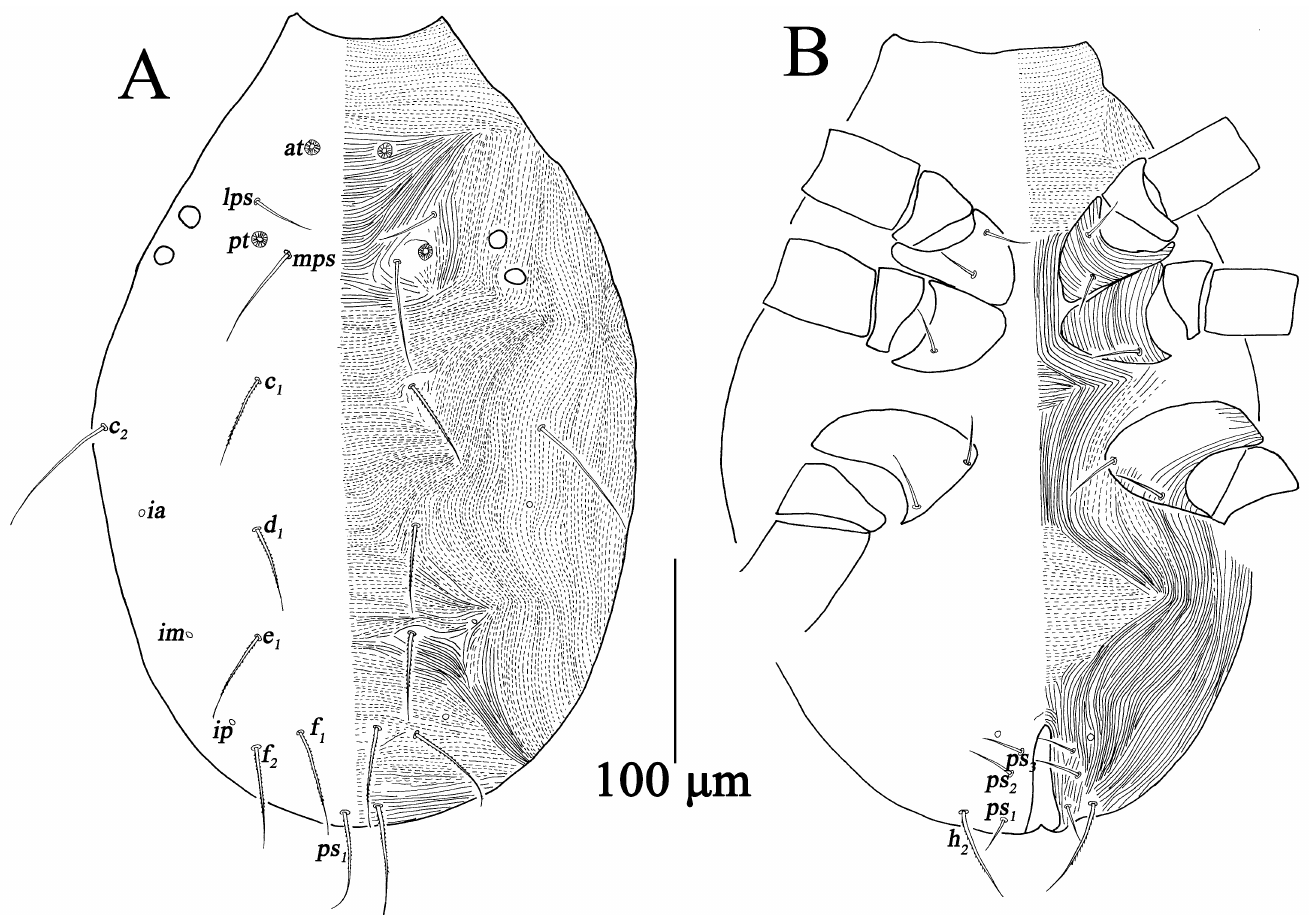
Figure 14. Bdella muscorum , larva: ( A ) Dorsal view of idiosoma; ( B ) Ventral view of idiosoma. Legs (Figure 13D – F). Measurements of legs as follows: leg I 206 – 249, leg II 193 – 225,